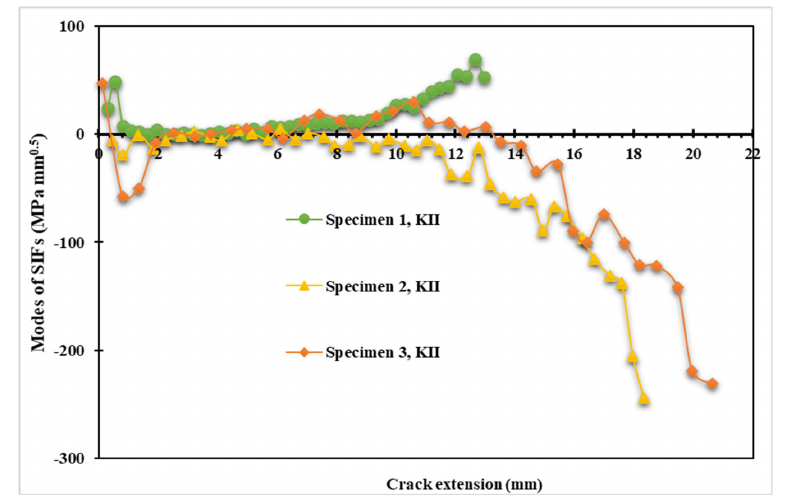
Figure 10. The second mode of SIFs versus crack length for the three specimens. Materials 2022 , 15 , x FOR PEER REVIEW